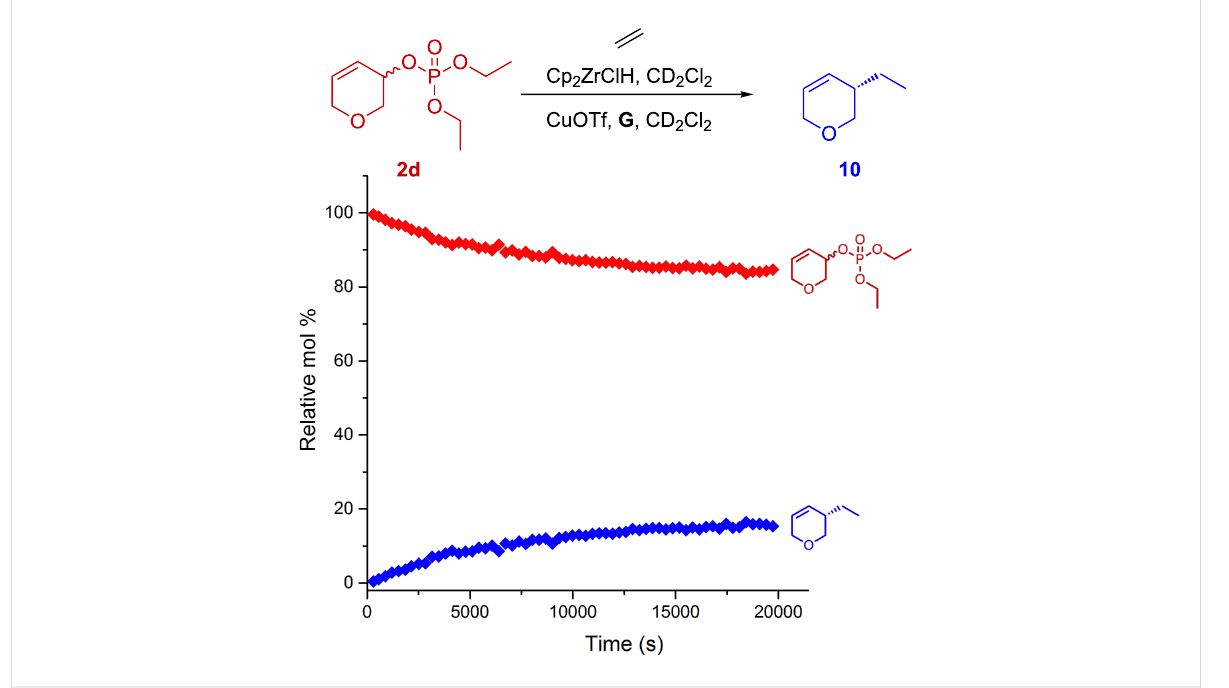
Figure 3: Reaction kinetics as monitored by in situ 1 H NMR spectroscopy from 3,6-dihydro-2 H -pyran-3-yl diethyl phosphate ( 2d ).